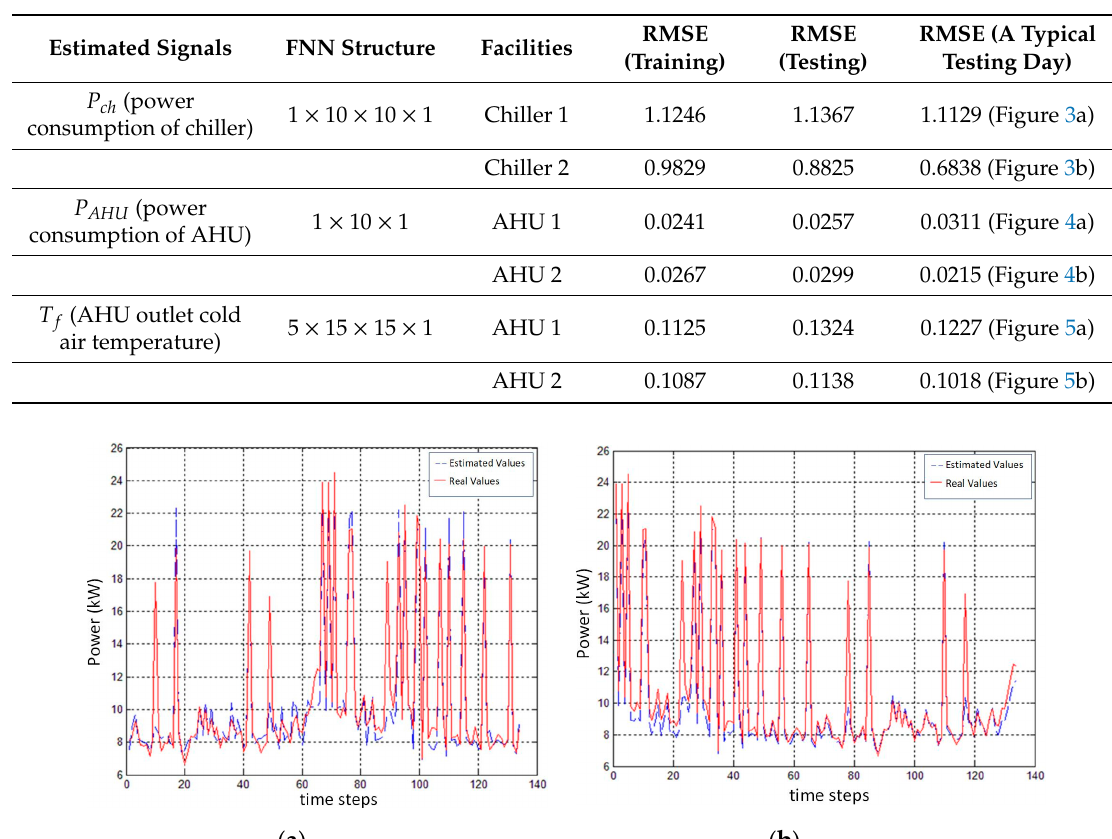
( b ) Figure 4. Comparison of air handling unit (AHU) power consumptions between estimated and real values for ( a ) AHU 1; ( b ) AHU 2. ( a ) ( b ) Figure 5. Comparison of predicted and real AHU outlet cold air temperature for ( a ) AHU 1; ( b ) AHU 2. 5.2. Experiments of Energy Saving In order to signify the effectiveness and efficiency of the proposed energy saving control scheme, the control scheme was applied from 19:50 to 23:50 on a typical summer night. It takes about 120 s in every sampling interval for the energy saving controller running the proposed multi-objective